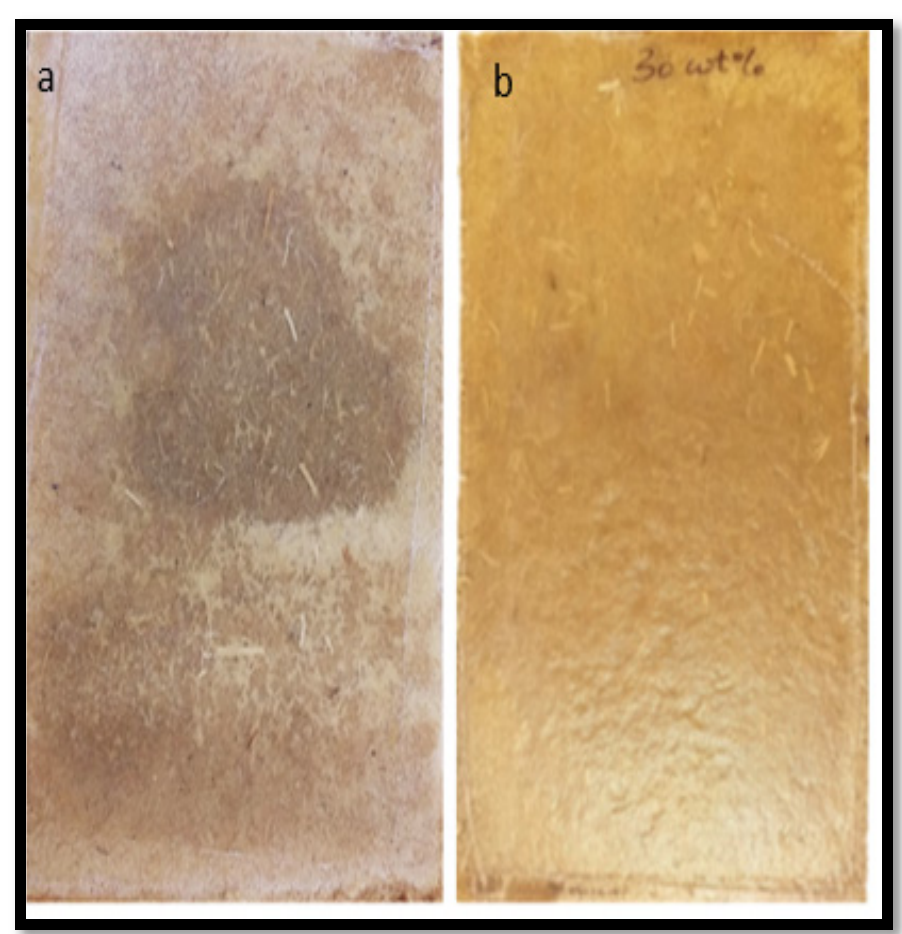
Figure 6. Example photographs of the composite surfaces made with polymer sheets of: ( a ) 0.24 and ( b ) 0.29 mm. Table 3. Ratio of thicknesses of polymer sheets to fibre mats in composites.